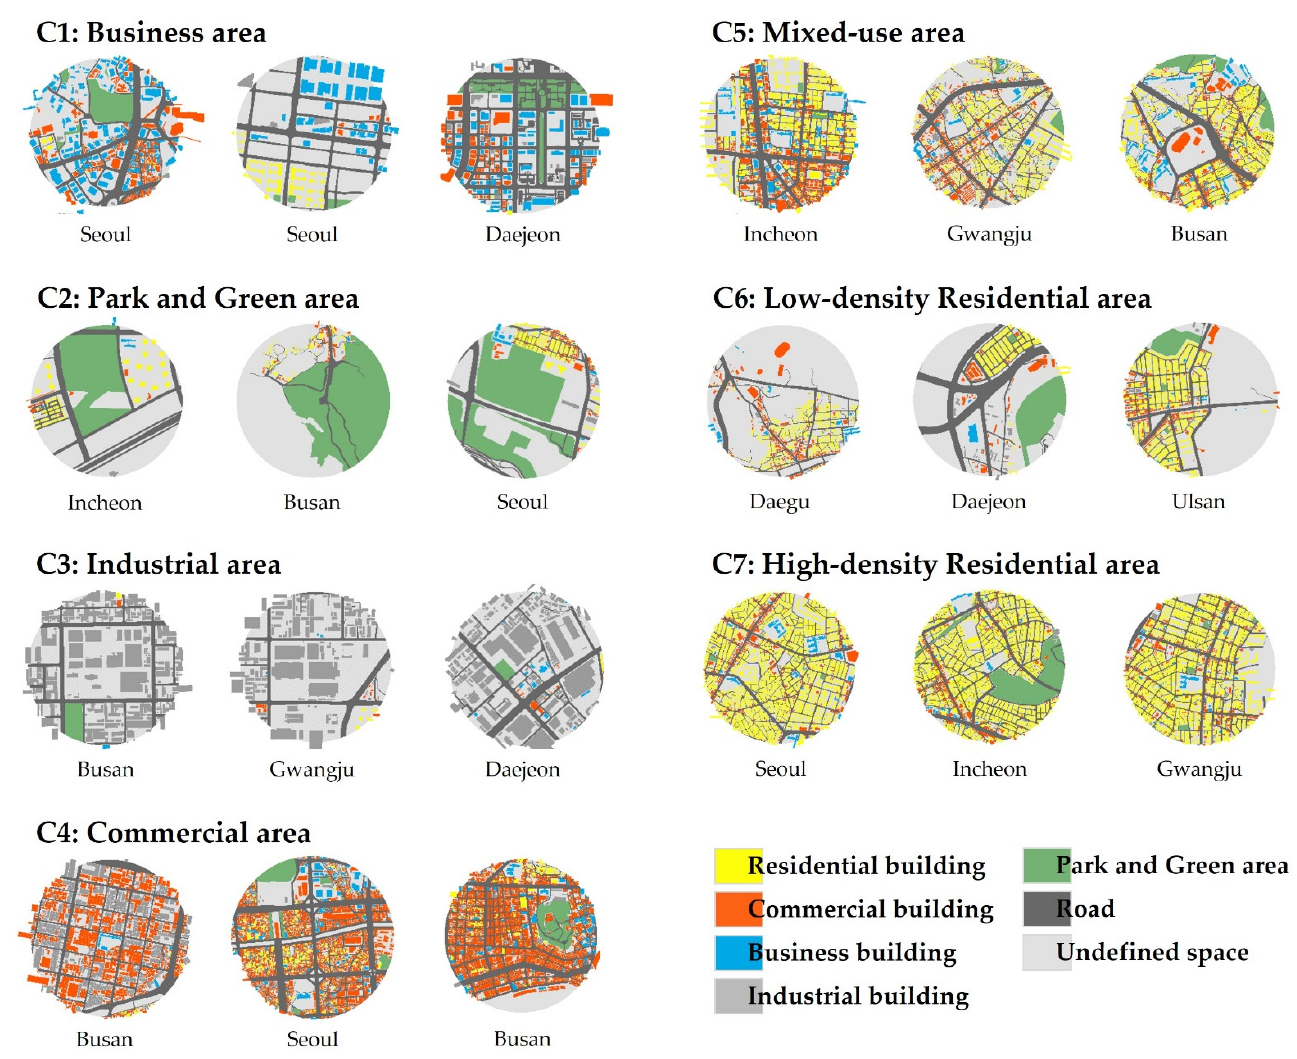
Figure 6. Representative case areas for each cluster: Each circle represents an area corresponding to a radius of 500 m from the AQMS. The AQMSs are located at the center of the circles. Whether the cluster analysis was performed properly can be checked through the visualization of land use around the AQMS. Table 3. Analysis of normality and differences in cluster analysis.